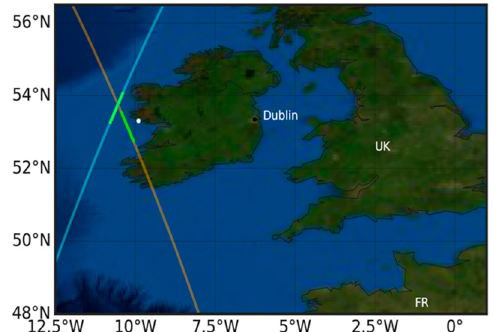
Figure 3. CALIOP orbit over Mace Head: The orange line represents the CALIOP daytime ground–track for a cloud–free case (18 / 11 / 14) at 13:41:22 UTC at 29.56 km distance from Mace Head whereas the blue line represents CALIOP nighttime ground–track for a case with a thin cloud (19 / 07 / 16) at 03:11:35 UTC at 60.11 km distance. The white dot represents the Mace Head station. The green dots represent the CALIOP profiles that were averaged (5 km, 15 km, 25 km, 35 km, and 100 km) and compared to Mace Head. The direct comparison of backscatter coe ffi cient at 1064 nm profiles measured by CALIOP (green lines) and Mace Head (blue line) with their respective standard deviations (shaded area) and the corresponding mean percentage di ff erence between the measurements is given in Figure 4 for (a, b) cloud–free case and (c, d) the case with a thin cloud. The di ff erent along–track averages performed in CALIOP data are represented by di ff erent line styles. According to [43], the blank spaces in CALIOP profile (green lines) are related to range bins were no particulates were detected.